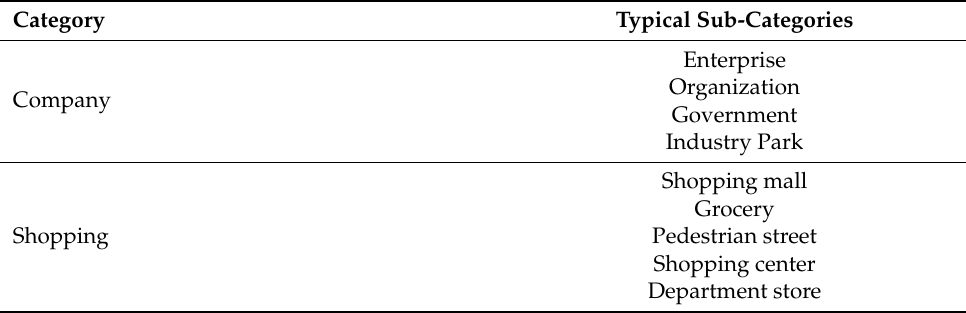
Table A1. The typical sub-categories of each POI